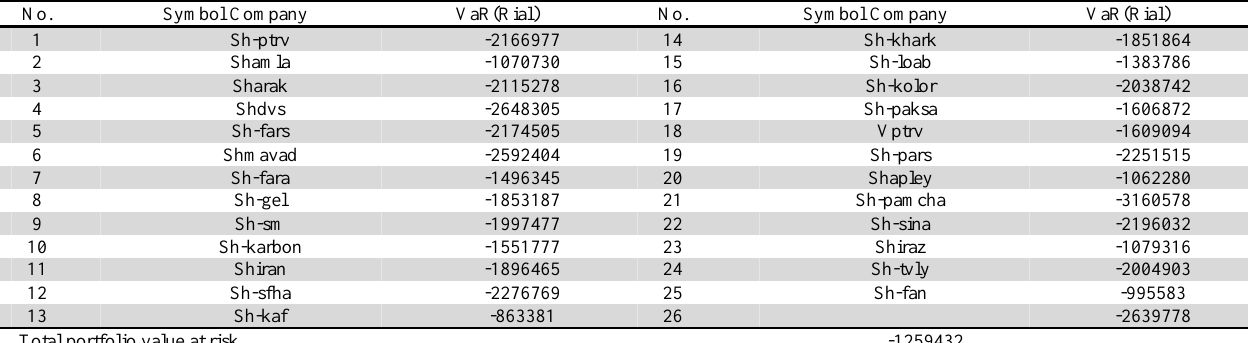
Stock VaR at 95% Confidence Level